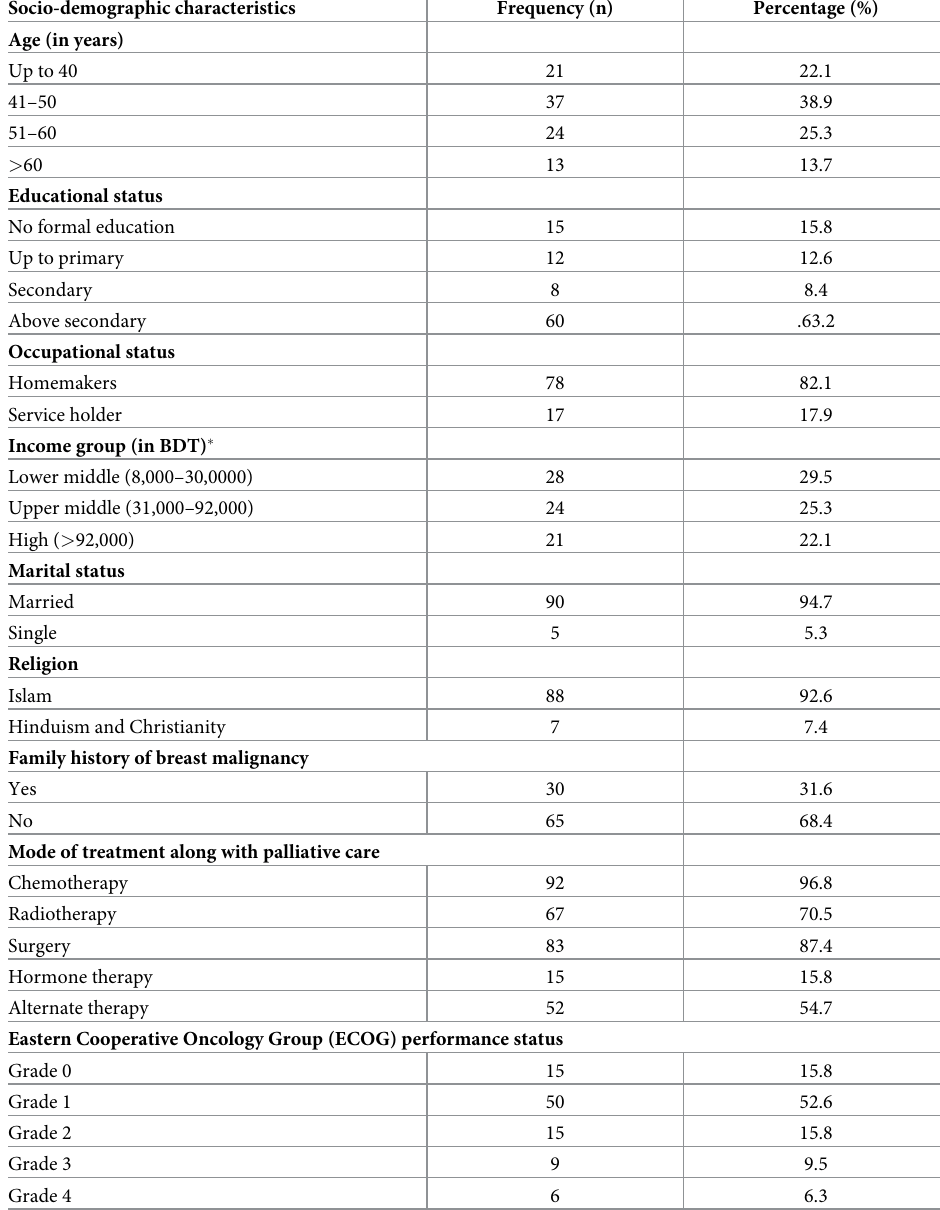
Table 1. Socio-demographic characteristics of the patients (n = 95). Socio-demographic characteristics